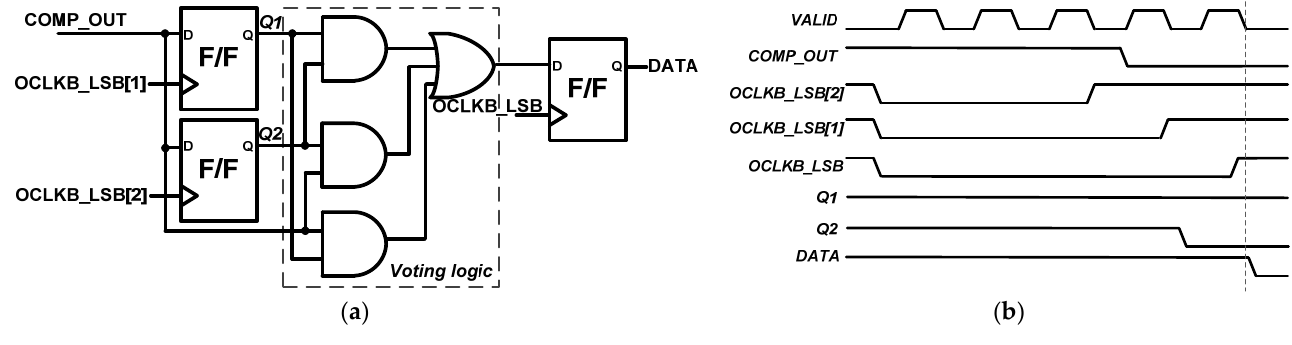
Figure 6. Voting logic: ( a ) block diagram; ( b ) timing diagram .